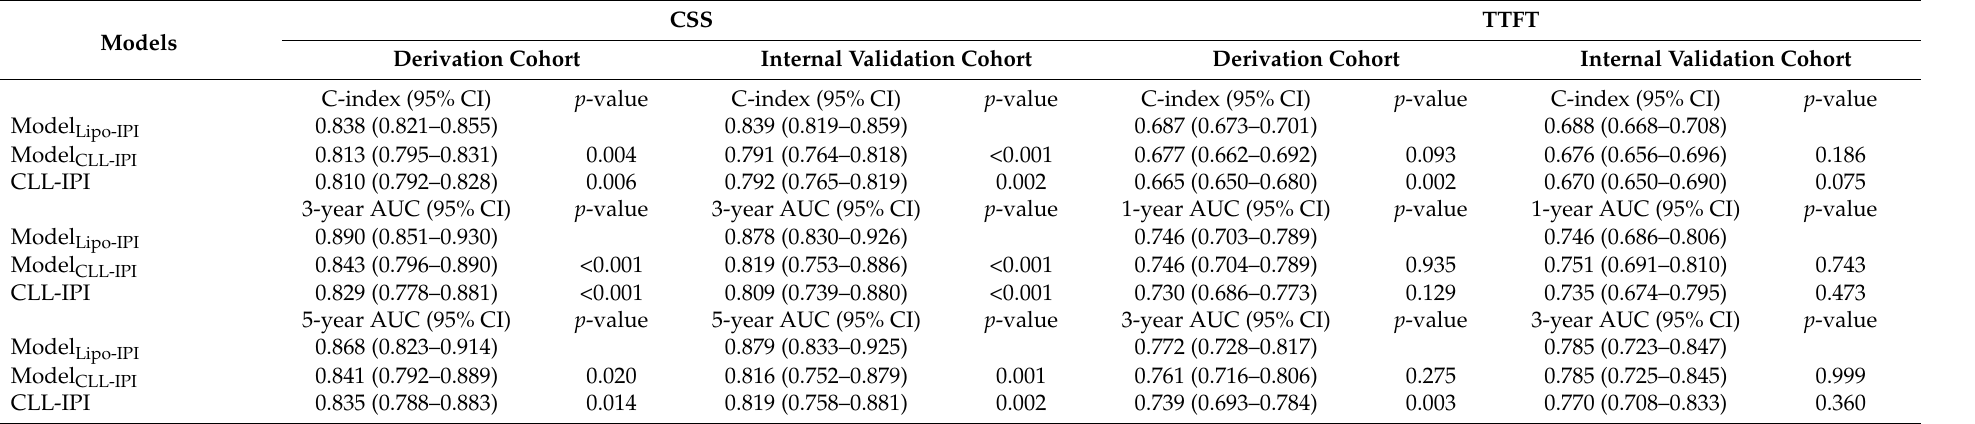
Table 3. Comparisons of C-indexes, 3-year and 5-year AUC between models and CLL-IPI in derivation and validation